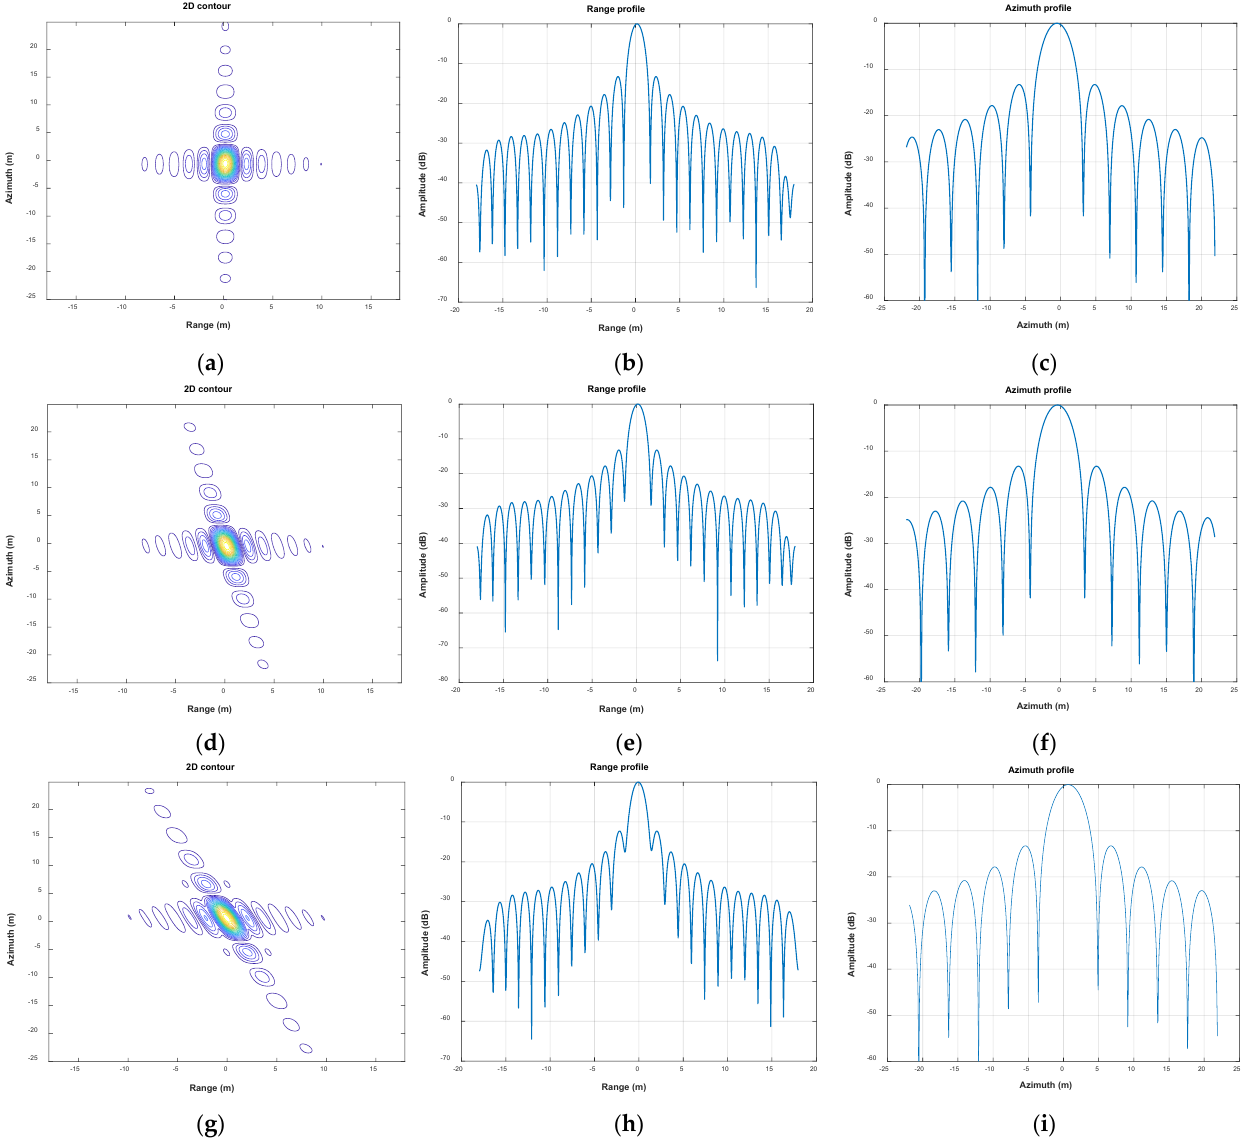
Figure 9. The 2D simulation results. ( a , d , g ) are the results with the squint angle of 0, 10, and 20 degrees, respectively; ( b , e , h ) correspond to the range profiles of ( a , d , g ), respectively, while ( c , f , i ) correspond to the azimuth profiles. Table 2. The analysis of the point target imaging quality.